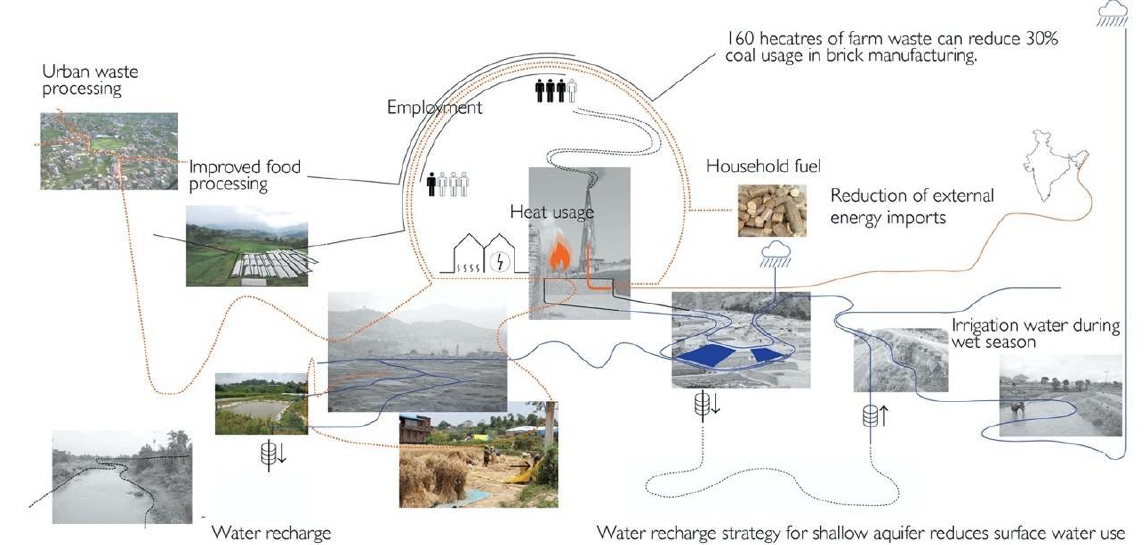
Figure 7. Design Strategy developed around the brick Kiln. Positioning the brick kilns' entrepreneurial nature as a hybrid resource centre for rural and suburban Kathmandu, with capacities to treat agricultural produce, rural and urban household waste. Source: